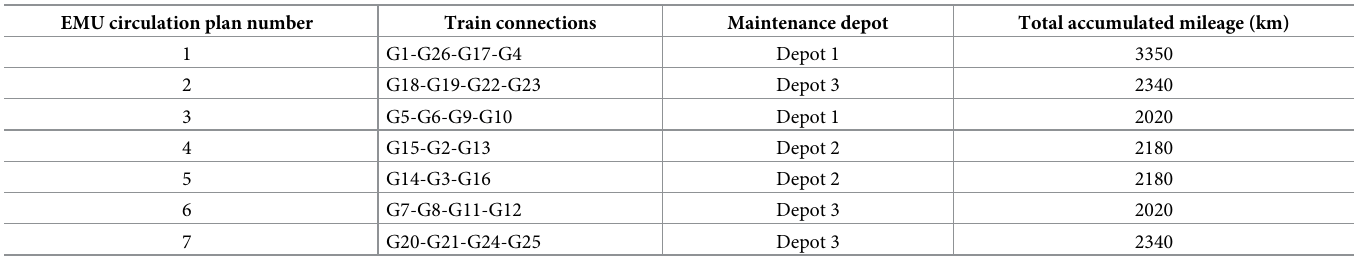
Table 7. EMU circulation plan.